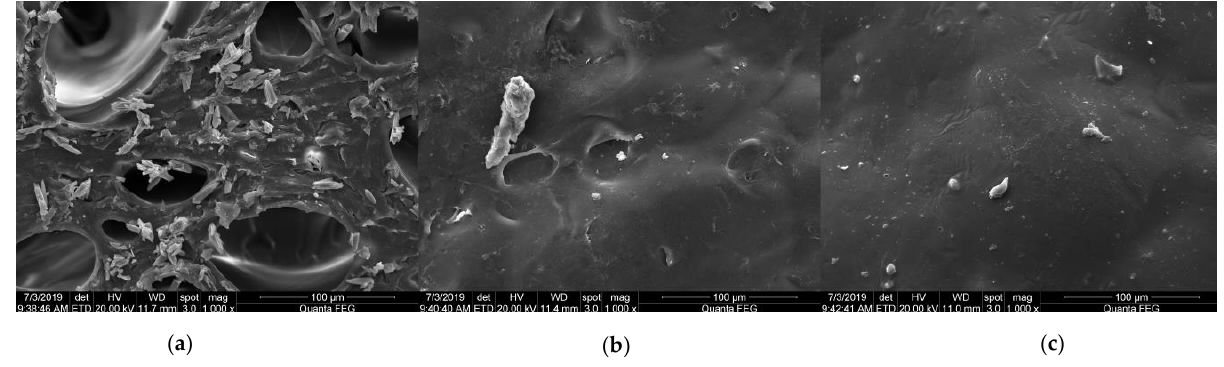
Figure 2. Microstructure of different films: ( a ) GF; ( b ) GBF; ( c )